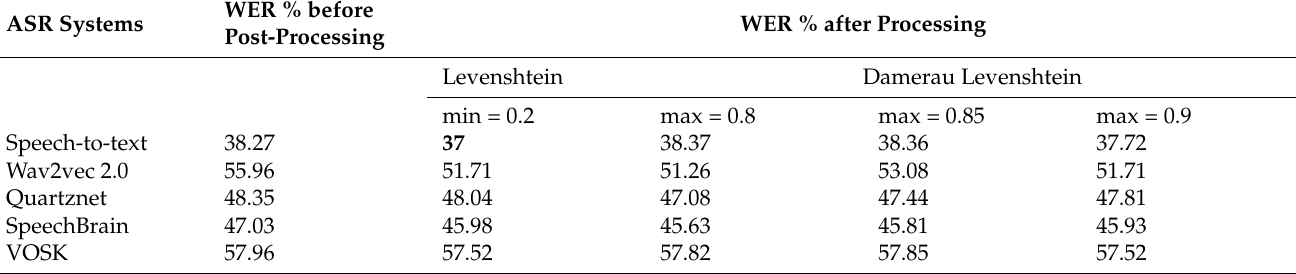
Table 4. Comparison of this method to different off-the-shelf ASR